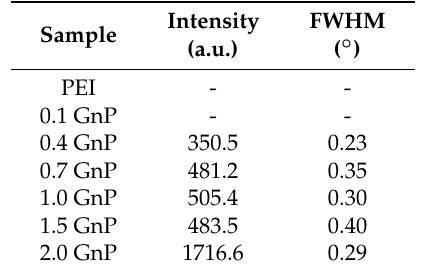
Table 2. Intensity and FWHM values of the characteristic (002) crystal diffraction plane of GnP in PEI and PEI-GnP nanocomposite